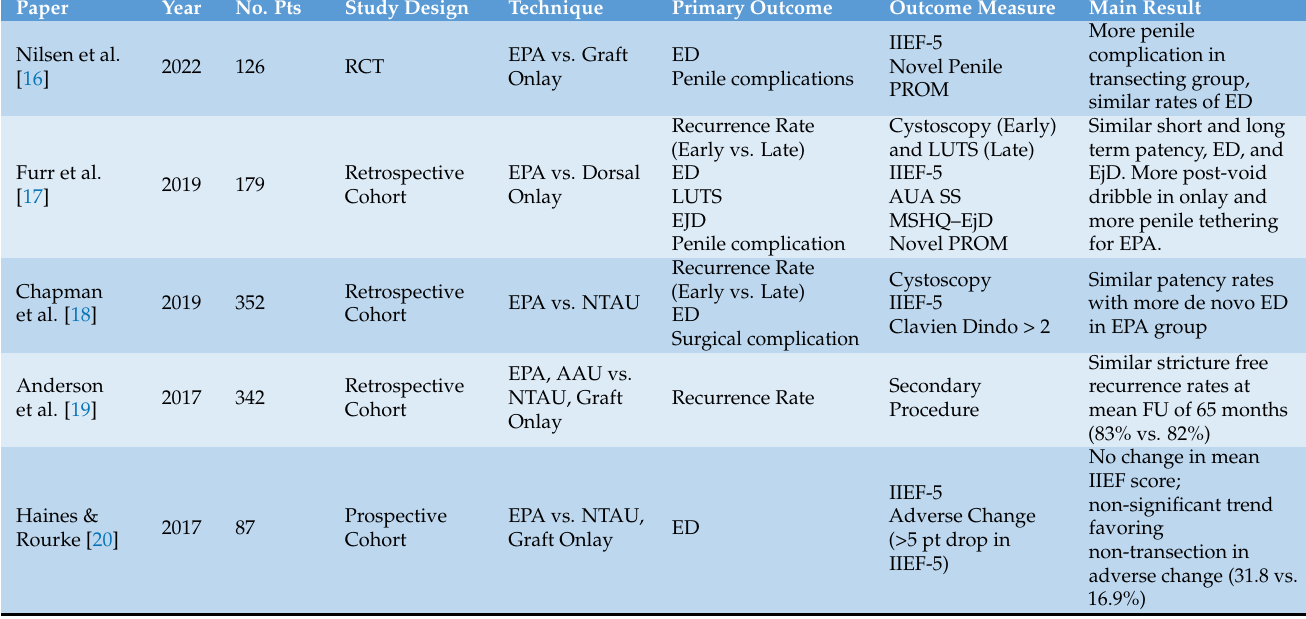
Table 1. Transecting vs. Non-transecting Bulbar